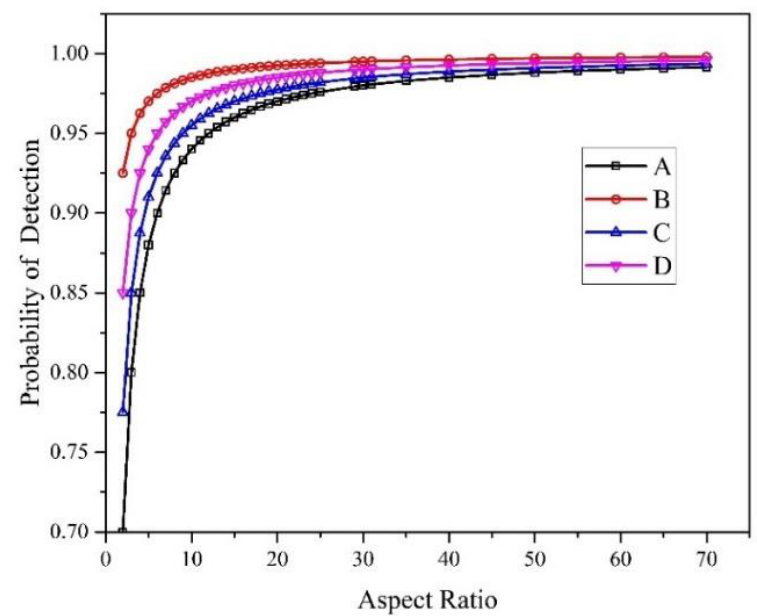
Figure 11. Probability of distribution curve of different methods for processing on CFRP samples ( a )/PLEXI samples ( b ) (confidence score = 0.75). Table 1. Class mark list—comprehensive